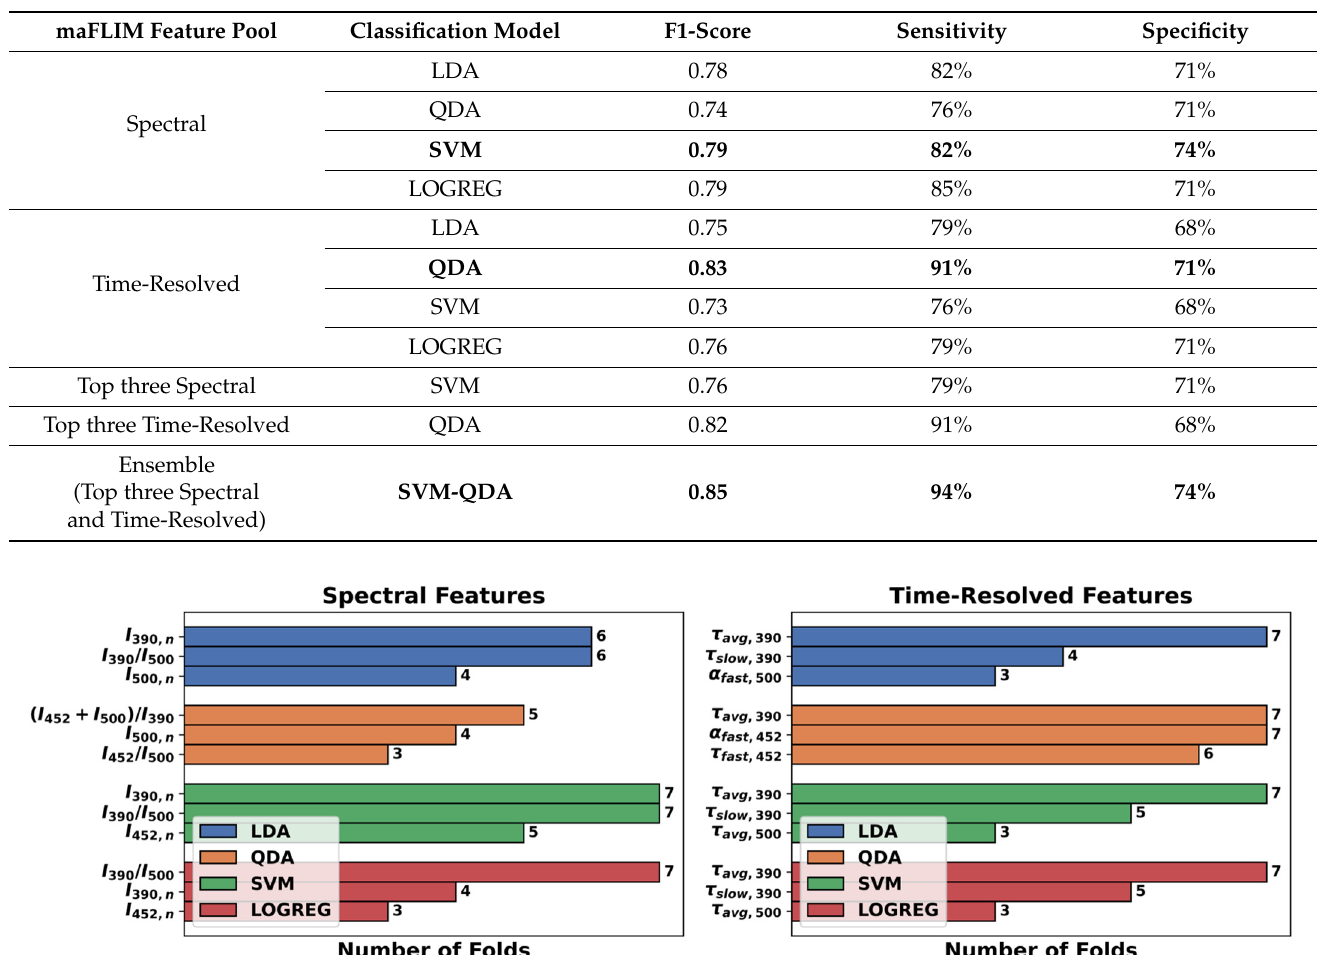
Confusion Matrices for Best Performing Mod-